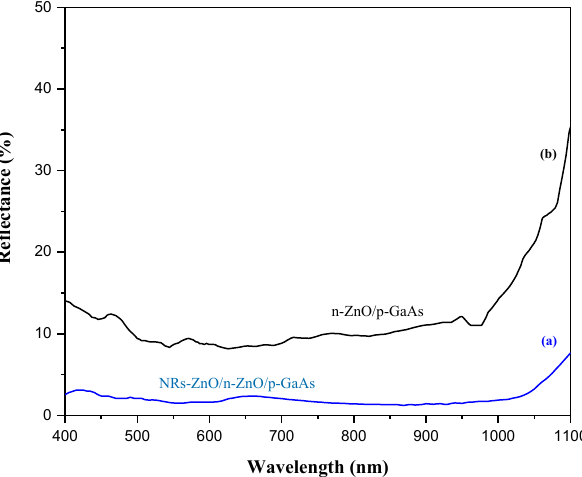
Figure 11. Reflectance spectra of the prepared heterojunction solar cells with (a) the presence of the nanorods ZnO layer grown on the emitter ZnO thin film, to form a double layer antireflective coating; and without (b).